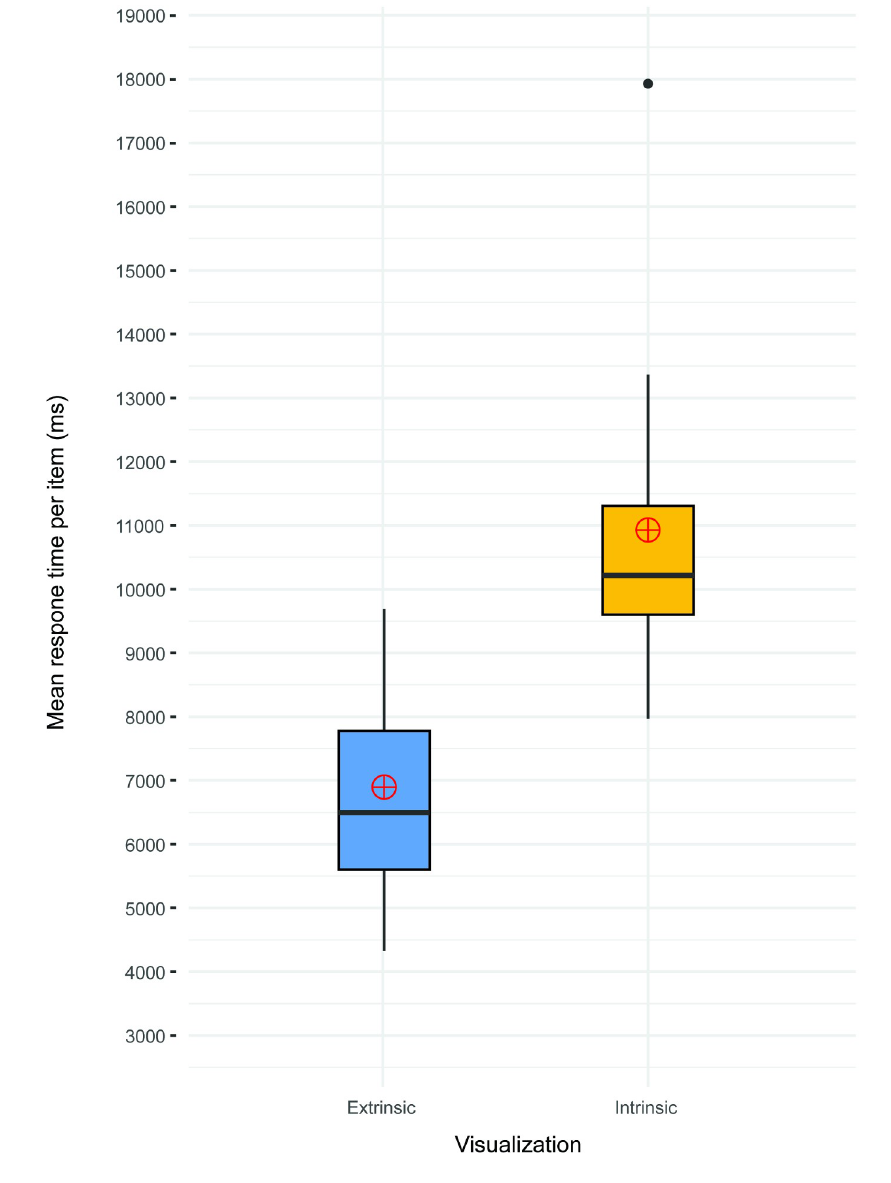
Fig 8. Mean response time per extrinsic/intrinsic visualizations (calculated from the response times to all extrinsic/intrinsic items for all participants).